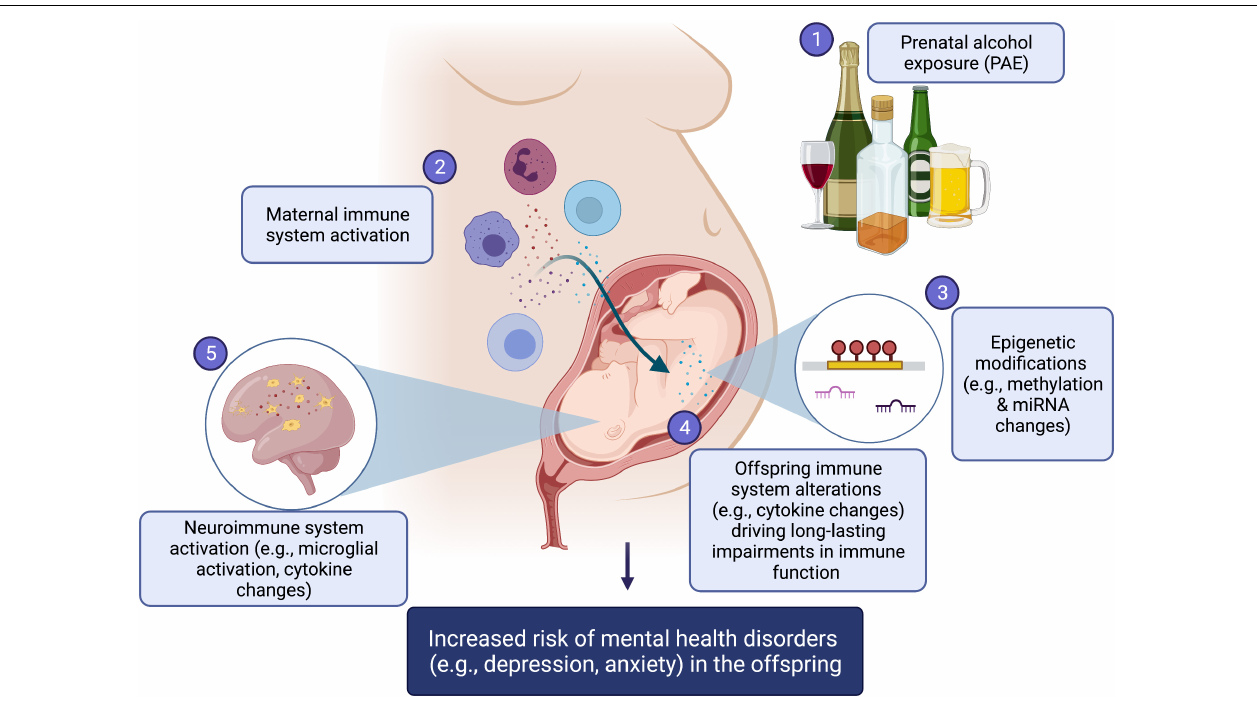
FIGURE 1 | Summary figure. (1) Prenatal alcohol exposure (PAE) can result in (2) maternal immune system activation, altering the fine cytokine balance during pregnancy, which in turn impacts the developing immune system of the fetus. In turn, both direct effects of PAE and alcohol-induced maternal immune activation may result changes in (3) epigenetic mechanisms, which include alterations to DNA methylation levels, histone modification patterns, and miRNAs expression levels. These epigenetic changes are likely important mechanistic drivers of (4) life-long impairments in offspring immune function and (5) neuroimmune system alterations, including microglial activation and central cytokine changes. Together, offspring central and peripheral immune system activation, by way of epigenetic changes, are hypothesized as driving, at least in part, the increased risk of mental health conditions, such as depression and anxiety, in alcohol-exposed offspring. Created with